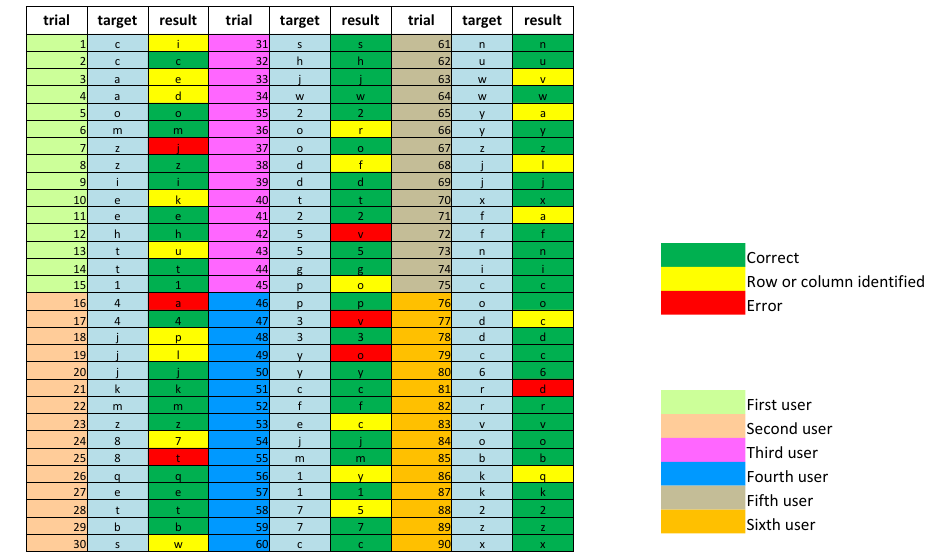
Figure 14. Detailed results obtained from 6 different subjects involved in experimental sessions of 15 trials. The correct results are green; the wrong results are yellow and red. Specifically, con- sidering the 28 cases of error, 22 instances refer to the situation in which the system can identify the row or column relating to the target icon (results in yellow), 6 in situations in which the system completely errs (results in red).